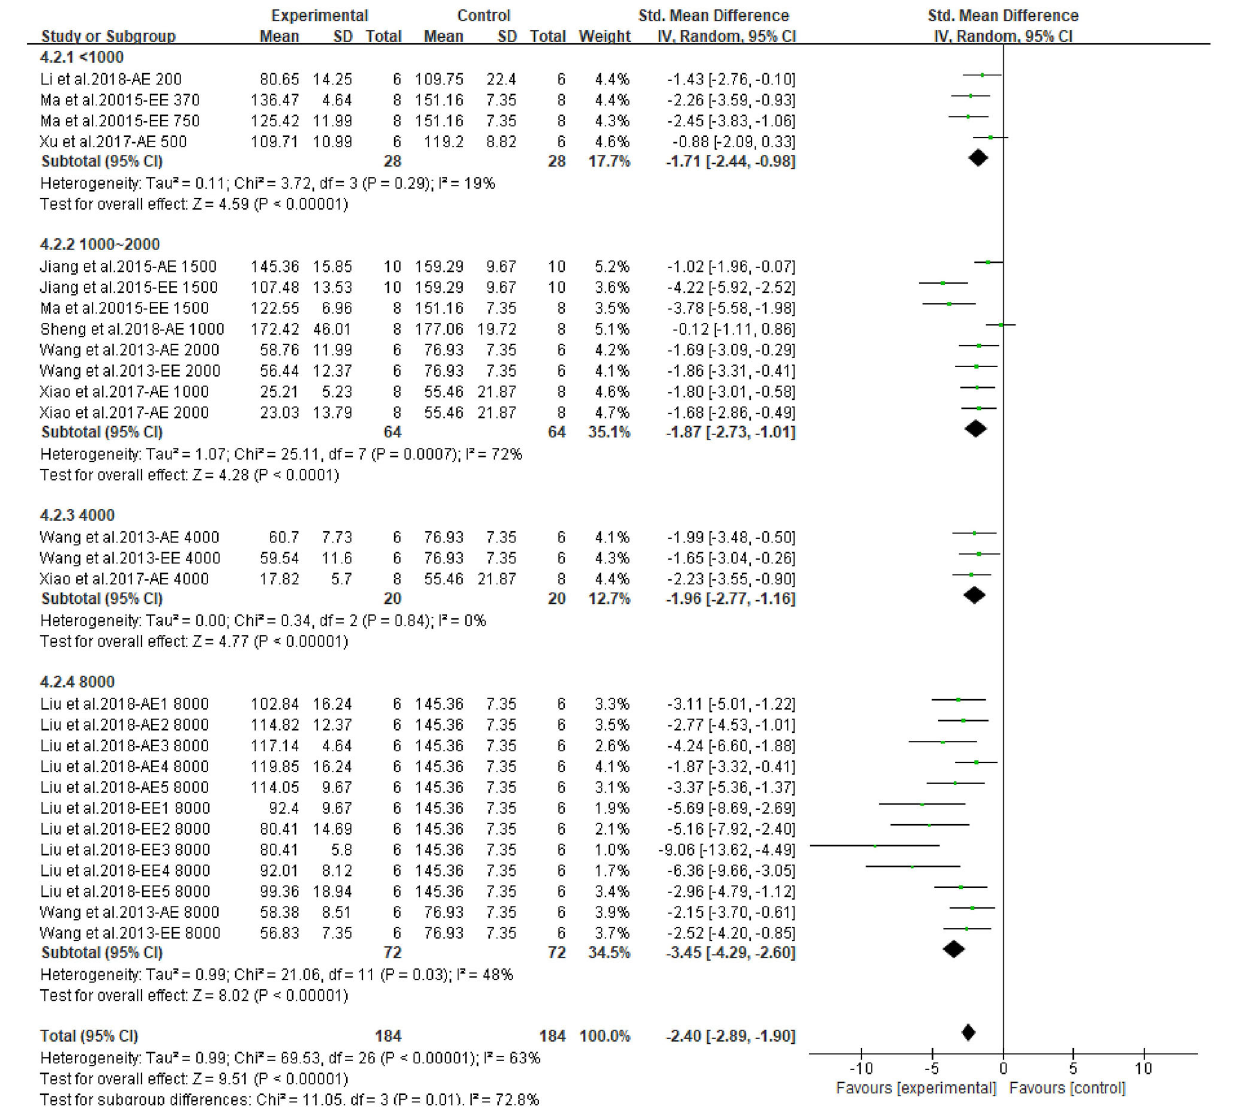
CP’s effect on regulating glucose homeostasis and